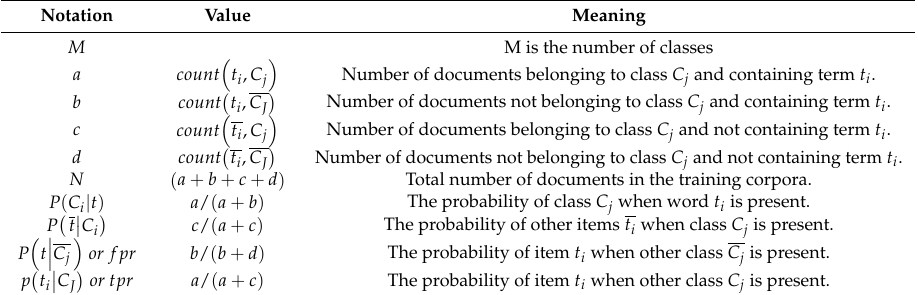
Table 8. Preliminary